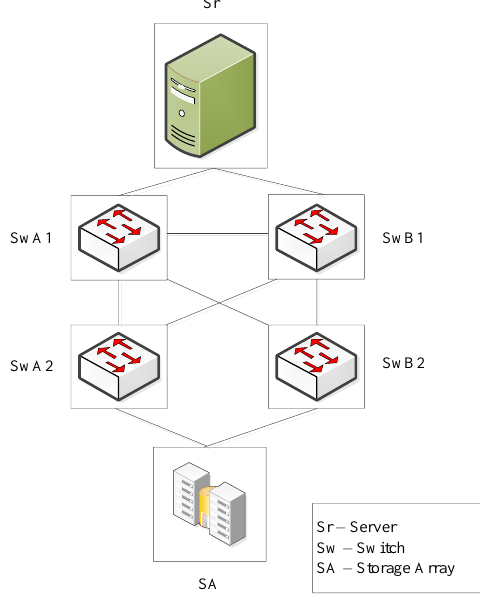
Figure 1. Example mesh SAN.